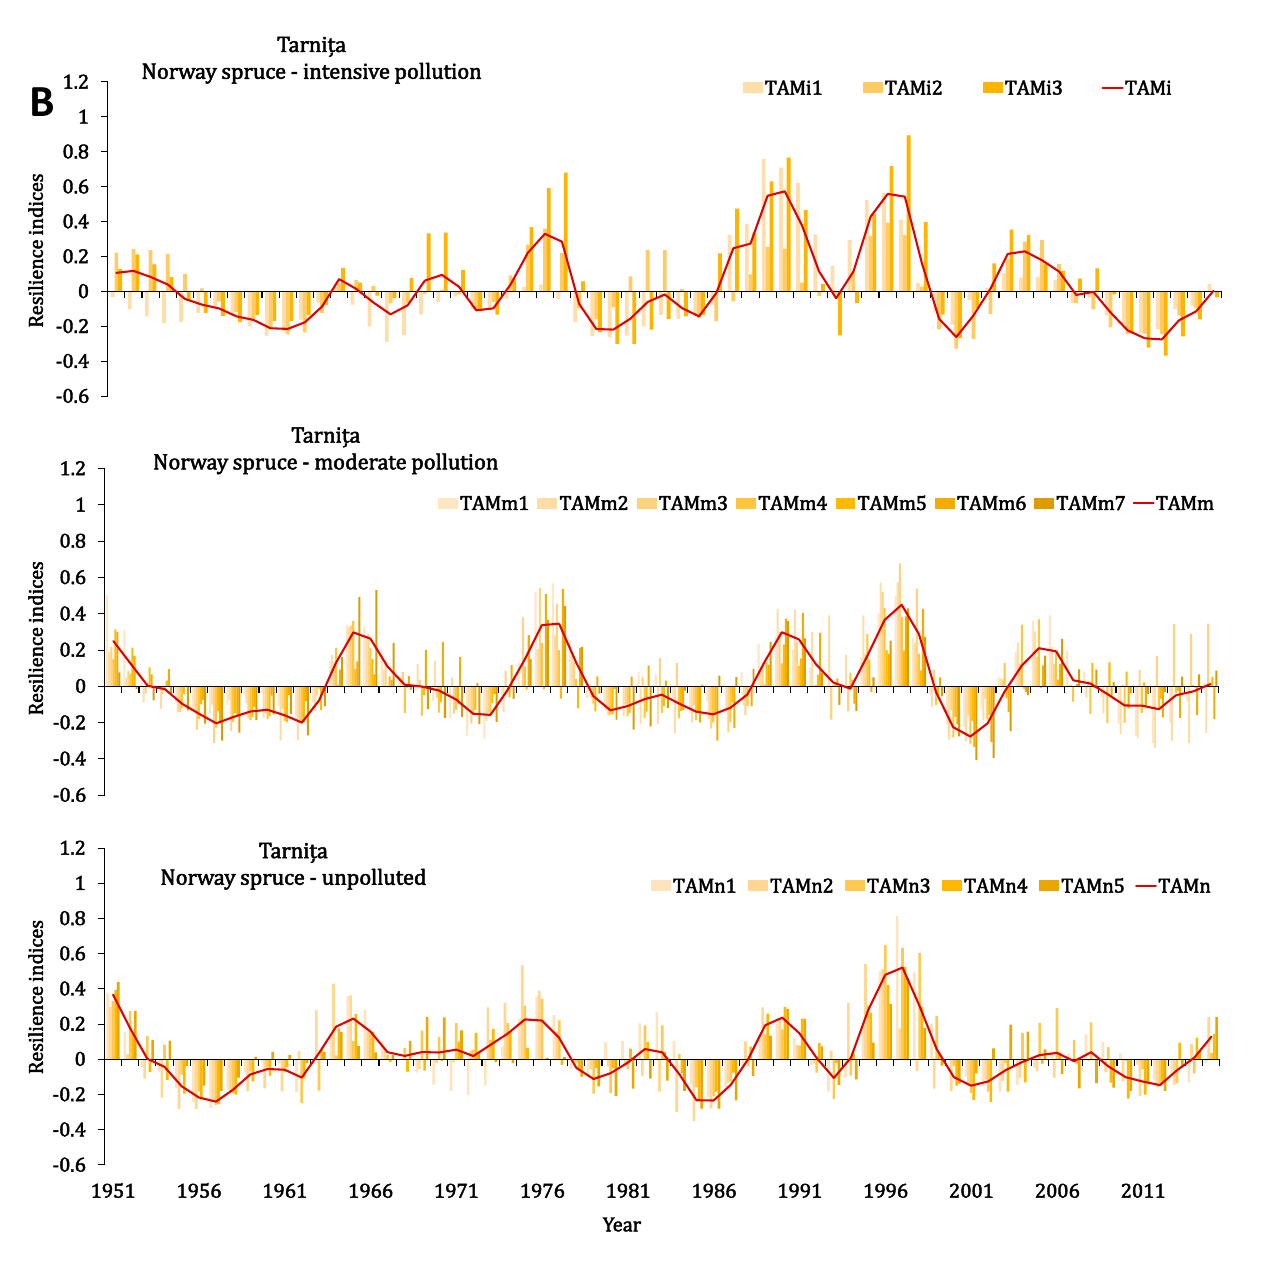
Figure 3. Resilience indices of the average radial growth series of silver fir ( A ) and Norway spruce ( B ). For intensely polluted silver fir trees, after the cessation of the polluting activity, the resilience index values were significantly higher than those of trees in unpolluted areas (Figure 4A). From 1978 to 1990, for the silver fir trees from the intensively polluted area, the resilience indices (Figure 3A) and average radial growth indices for Norway spruce (Figure 4B) were much lower than those of the silver fir trees in the unpolluted areas. The quantification of growth losses for silver fir reflects reductions of up to almost 20% (in 1984 and 1989) in heavily polluted areas (Figure 5A). The growth losses of trees located in moderately polluted areas were not as significant (up to 5–7% relative to normal). The average losses throughout the highlighted period for heavily polluted silver fir were approximately 14%. Compared to the silver fir tree, the Norway spruce suffered much smaller diameter growth losses (Figure 5B). The average loss of diameter growth of the intensively polluted Norway spruce during the entire period of pollution exposure was 5%, and the loss was only 2% for the moderately